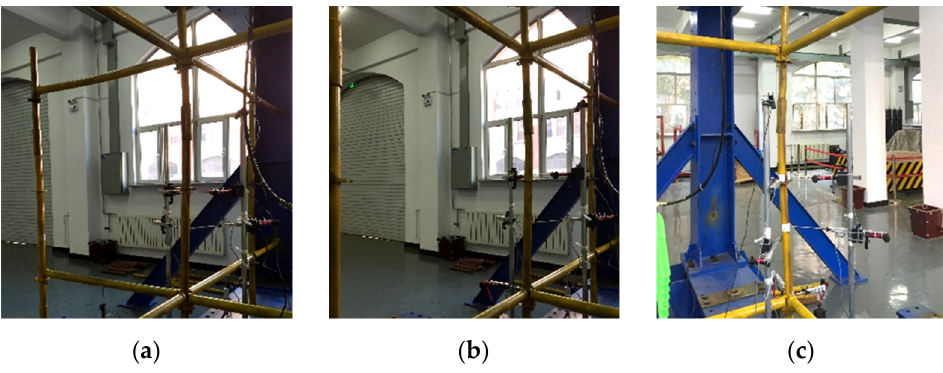
Figure 26. Failure modes of double-layer vertical poles: ( a ) Central pole; ( b ) side pole; ( c ) corner pole.